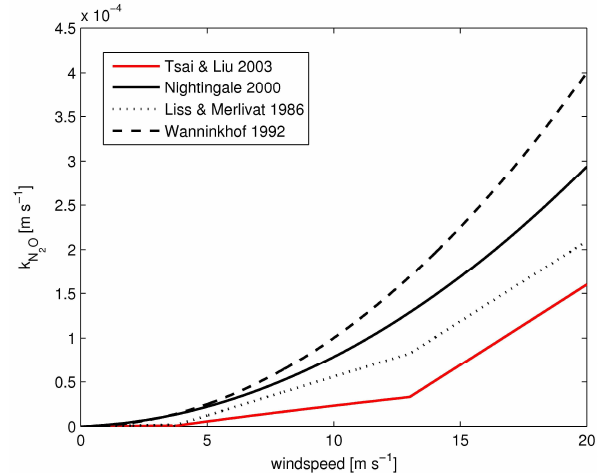
Fig. 2. Wind speed parameterizations used for the calculation of sea-to-air fluxes of N 2 O. The black lines represent gas exchange parameterizations for conditions without surfactants while the red line represents the parameterization of Tsai and Liu (2003) for surfactant-influenced surface